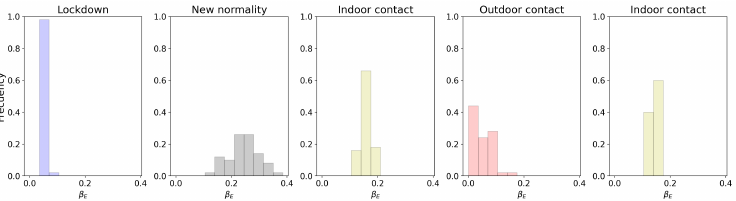
Figure 21. Histogram of the 50 different provinces of Spain. The value of β E at the different levels of lockdown registered in 2020.